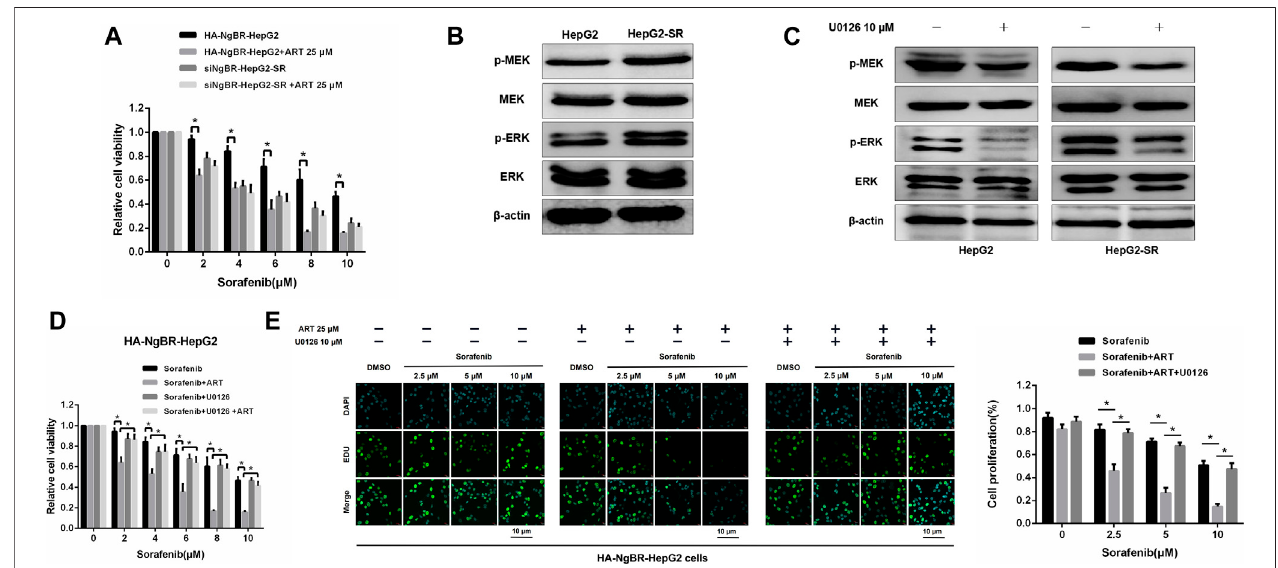
FIGURE 6 | Artesunate (ART) overcomes NgBR-induced sorafenib resistance by suppressing the MEK/ERK pathway. (A) . MTT assay detected proliferation in HepG2-SR cells with NgBR downregulation and HepG2 cells with NgBR overexpression after treatment with sorafenib alone or in combination with artesunate. (B) . Phosphorylation levels of MEK (p-MEK) and ERK (p-ERK) in HepG2 and HepG2-SR cells were detected by western blot. (C) . HepG2 and HepG2-SR cells were treated with 10 μ m U0126 for 7 days to inhibit p-MEK and p-ERK. Western blot was used to determine inhibition ef fi ciency. (D) . HepG2 cells with NgBR overexpression were treated with 10 μ m U0126 for 7 days, and MTT assays were used to detect the artesunate-induced sorafenib sensitization. (E) . EDU assays were used to detect theproliferationinHepG2cellsoverexpressingNgBRandtreatedwith10 μ mU0126for7 days.Scalebars,10 μ m.Experimentswererepeatedthreetimesanddataare presented as means ± standard deviation (SD). Student ’ s t -test was used for data analysis. * p <